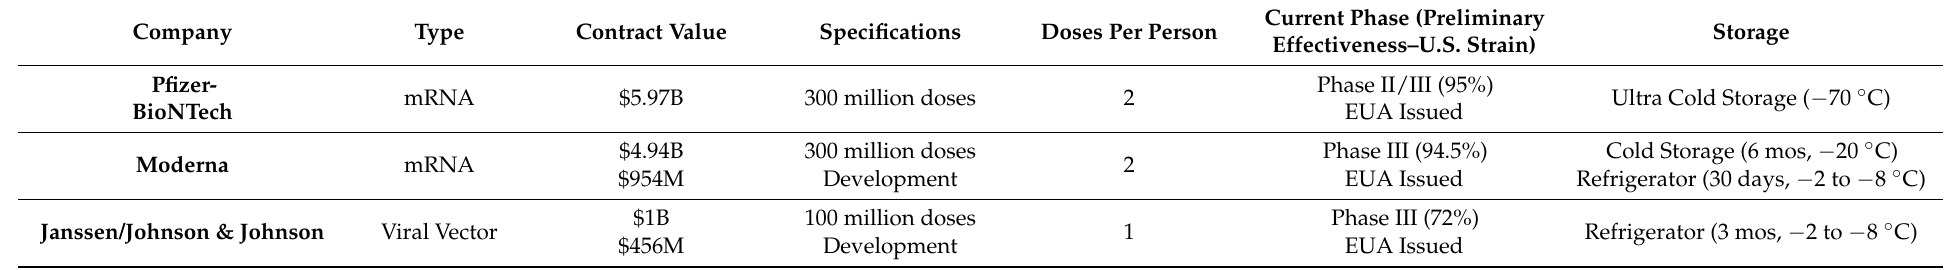
Table 6. Vaccine candidates supported by BARDA and other federal agencies, reproduced from the Congressional Research Service (CRS) Insight IN11560 [108]. Company